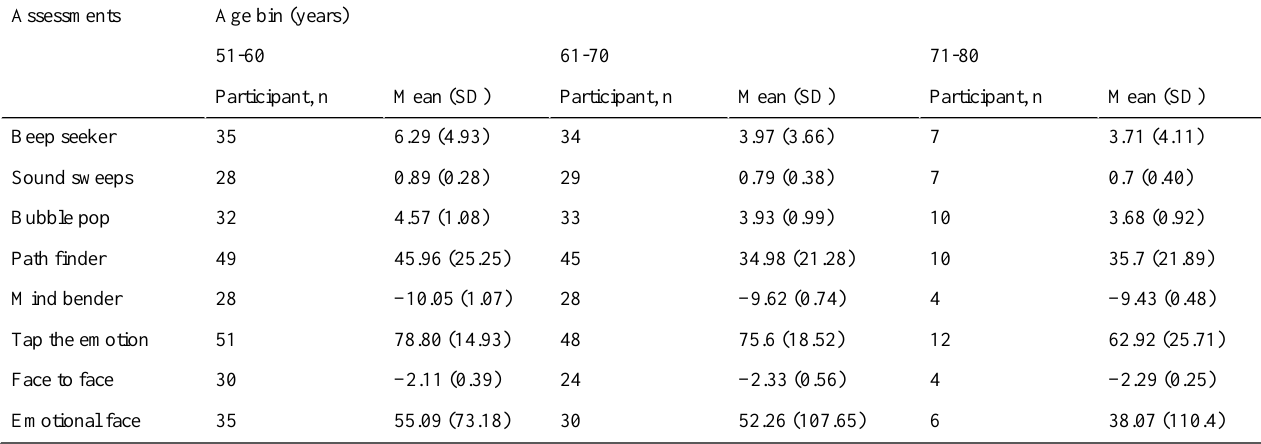
Table 6. Normative data by age bin for ages 51-80